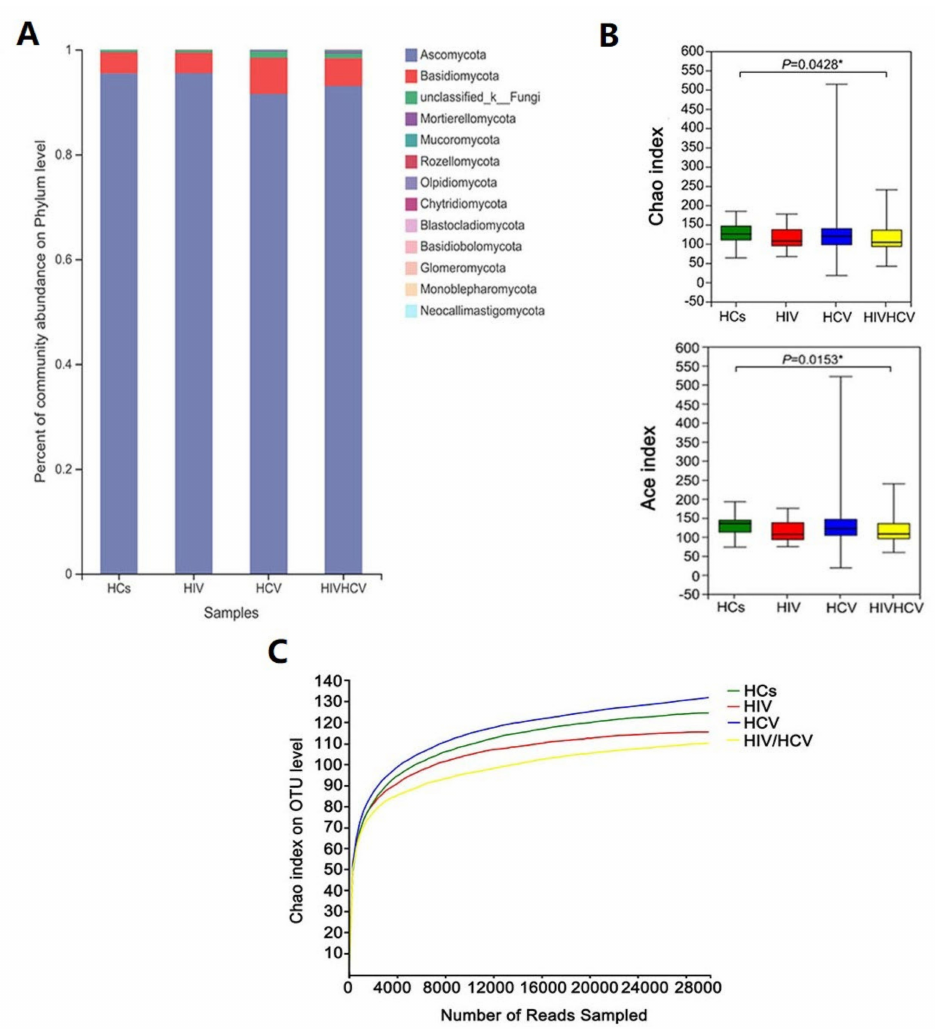
Figure 1. Taxonomy and alpha diversity of the four groups. ( A )The community histograms at phylum level. ( B ) Chao and ACE diversity index of the four groups. ( C ) Rarefaction curves of Chao index at out level. Clustering was performed by Uparse 7.0.1090. Each curve represents the average of all repeats ( ± standard deviation) for each group of samples (HCs, HIV, HCV, and HIV/HCV). * p < 0.05, determined by unpaired Student’s t